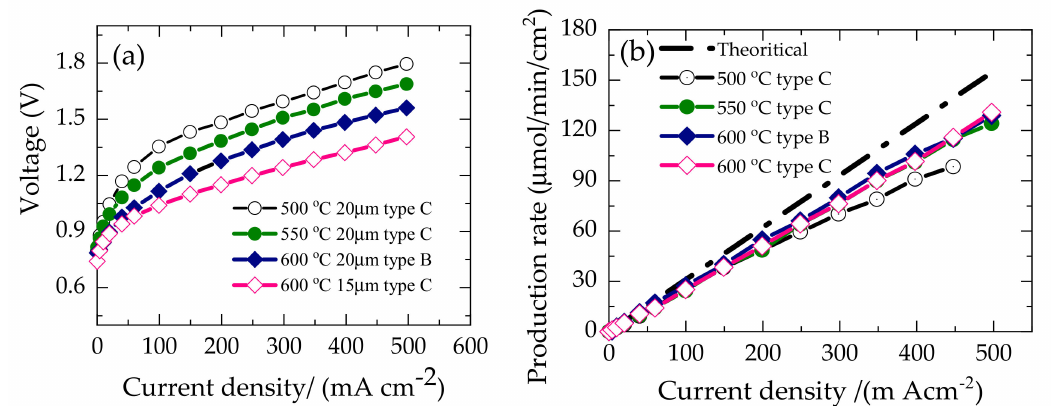
Figure 11. ( a ) Temperature dependence I–V characteristic of the as-fabricated steam electrolysis cells based on Type B and C half-cell configuration ( b ) Hydrogen evolution rate measured at 500, 550, and 600 ◦